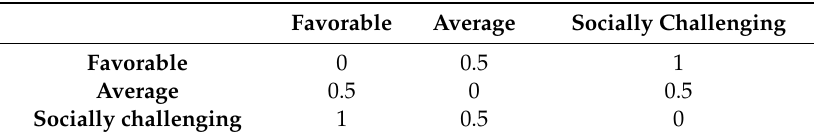
Table 5. Comparison criterion for feature “environment”.